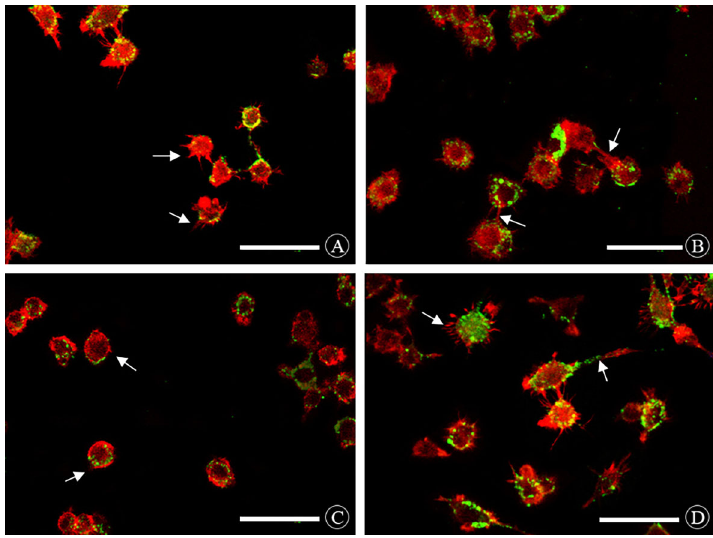
Figure 3. Cytoskeleton morphology of each group under laser confocal microscope ( (cid:1) 400, scale bar, 15 m m). A , Blank group: protruding long fi lamentous pseudopodium, cell deformation was obvious. B , Negative control group: protruding long fi lamentous pseudopod, cell deformation was obvious. C , PI3K-RNAi group: short protruding pseudopod, cell deformation was poor. D , mTOR-RNAi group: longer and denser protruding pseudopod, cell deformation was more obvious. Red fl uorescence: rhodamine labeled phalloidin; Green fl uorescence: FITC- E.coli . White arrow: